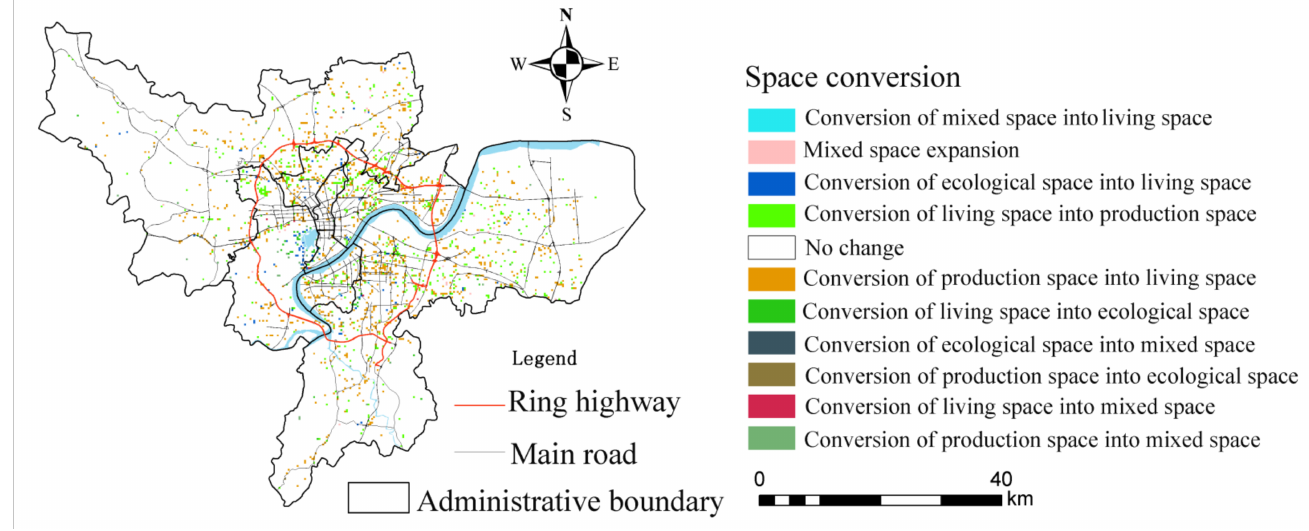
Figure 5. Spatial distribution of mutual transfer among production, living, ecological spaces in Hangzhou between 2010 and